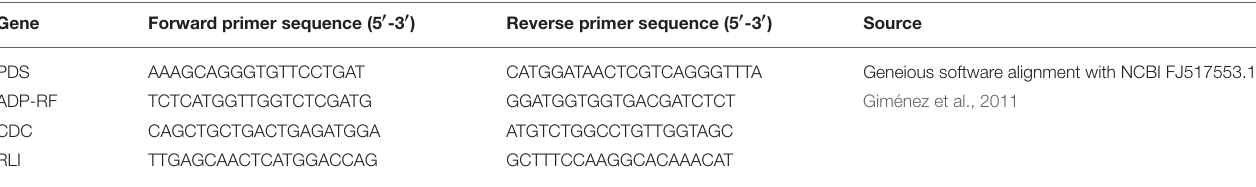
TABLE 1 | Primer-set Sequences for RT-qPCR. Gene Forward primer sequence (5 ′ -3 ′ ) Reverse primer sequence (5 ′ -3 ′ ) PDS